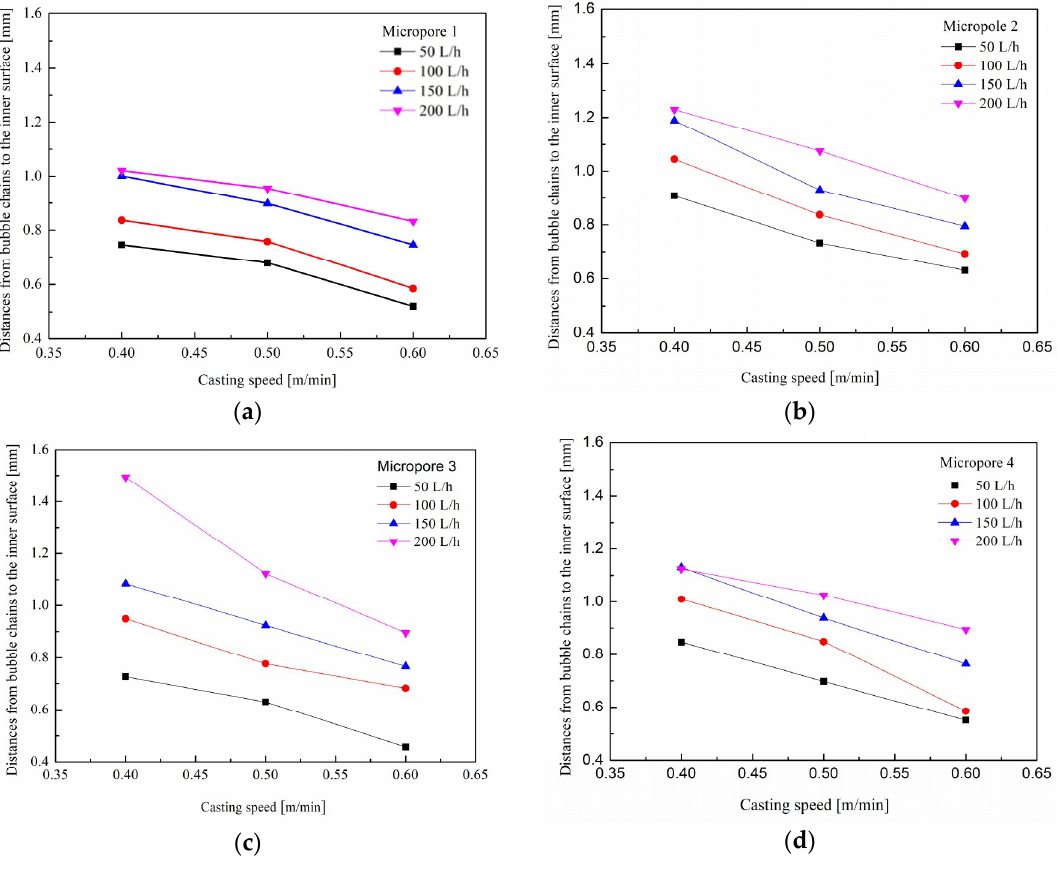
Figure 13. Measured distances from bubble chains to the inner surface of the nozzle for different casting speeds and argon flow rates: ( a ) Micropore 1; ( b ) Micropore 2; ( c ) Micropore 3; ( d ) Micropore 4.